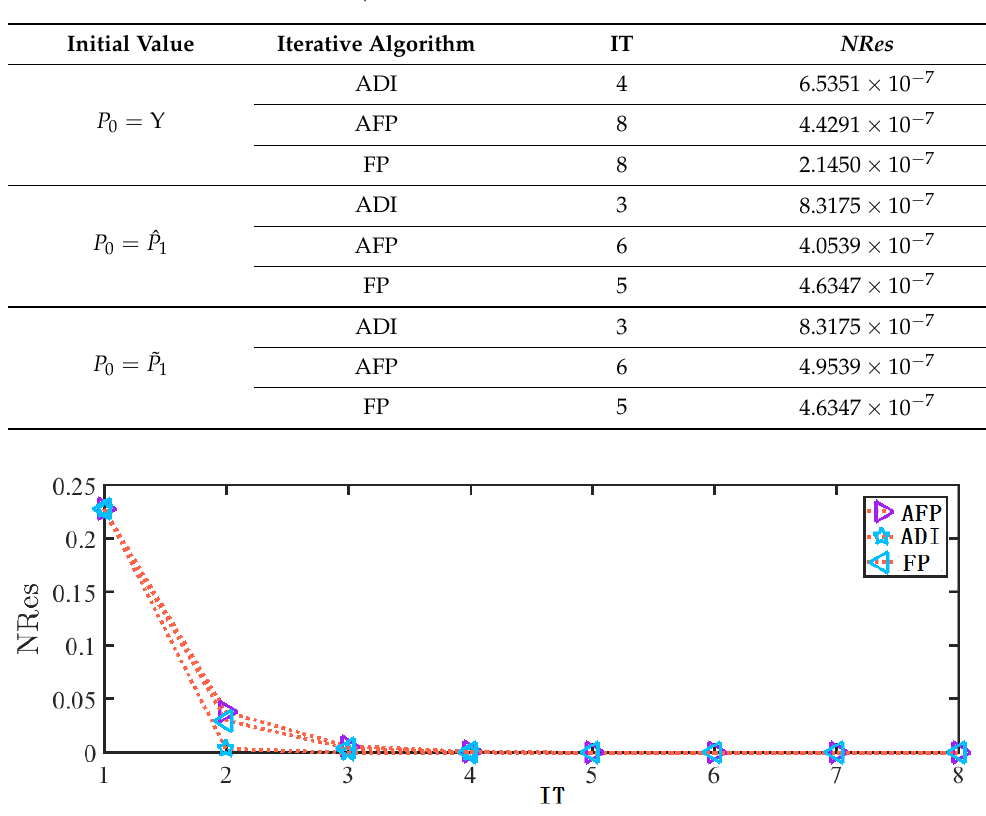
Table 2. The numerical results of FP, AFP and ADI when θ = 0.5.